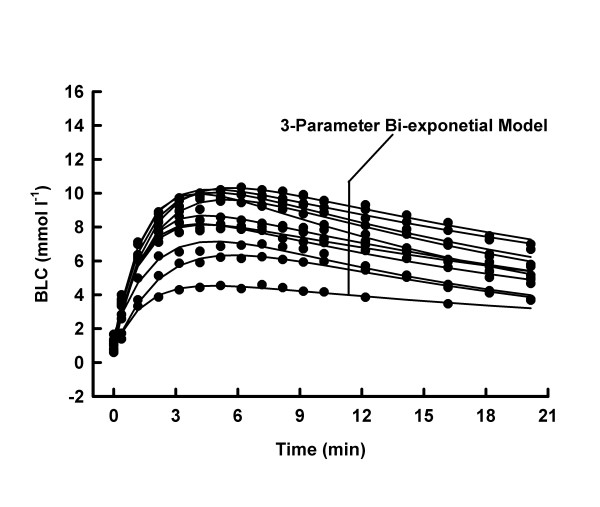
BLC, individual 3-parameter model approximations for MSE10.